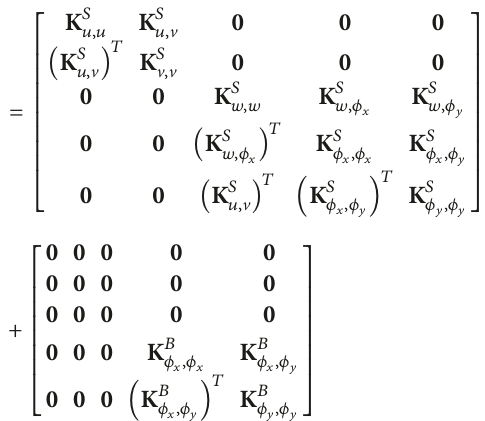
Figure 11: Vibration displacement response of the 8-point elastic supported laminated plate on the various elastic foundations.